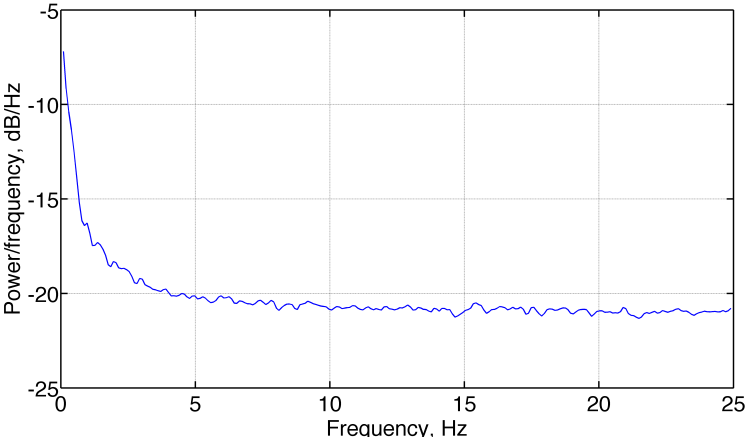
Figure 1. Pressure altitude noise spectrum from a barometric